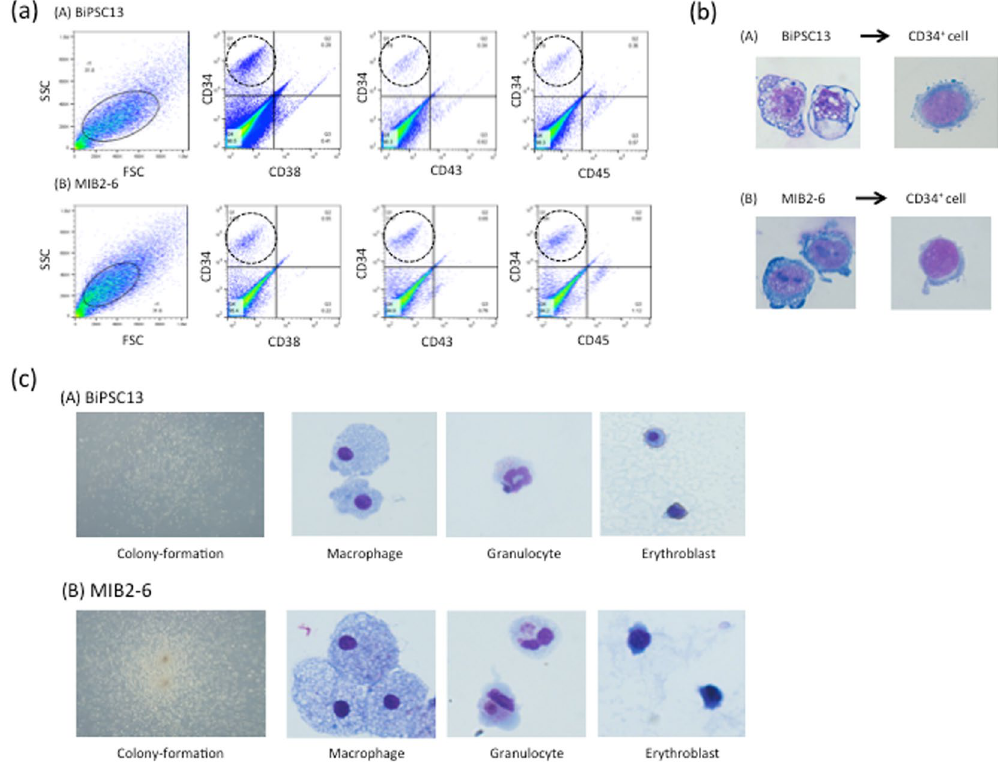
Figure 4. Hematopoietic progenitor cells differentiation of BiPSCs. ( a ) Flow cytometric analysis of the cell phenotype after differentiation of BiPSCs into HPCs. (A) BiPSC13, (B) MIB2-6. The population of CD34- positive cells is surrounded by a dotted line. ( b ) Representative morphology (x1000) and Wright stain of BiPSC13 (A) and MIB2-6 (B) cells before and after differentiation into CD34 + cells. ( c ) Morphology of formed colonies (x50) and Wright staining of cytospins picked up from a colony (x1000). (A) BiPSC13, (B)